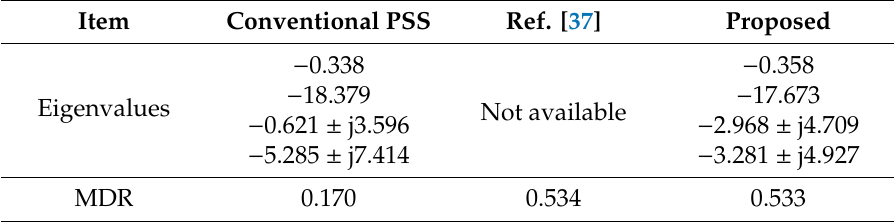
Table 9. Eigenvalues and MDR comparison for the operating situation # 3 (first